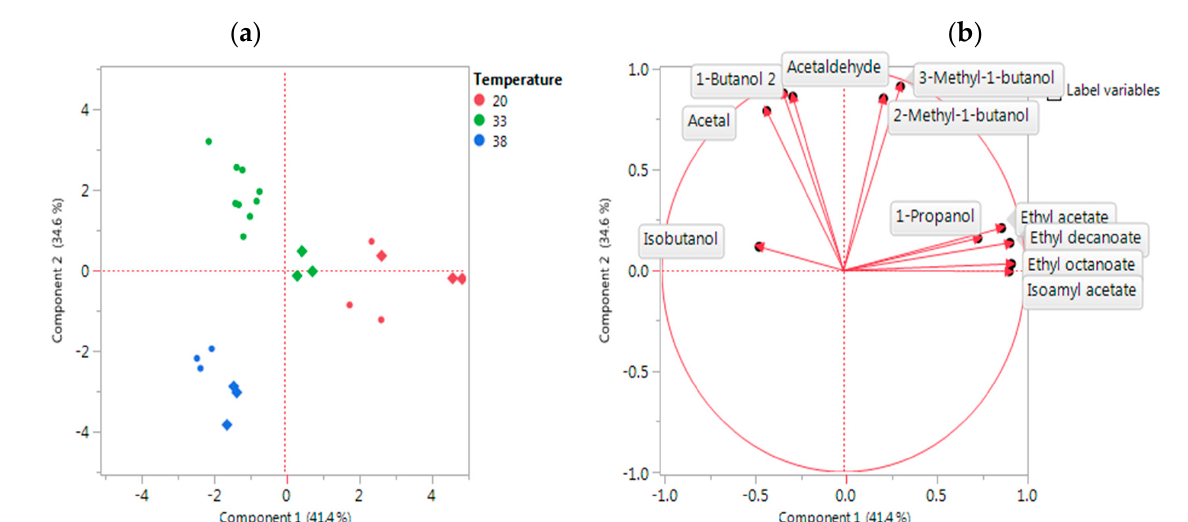
Figure 2. PCA of congener data obtained following corn-whisky fermentation at 20 ◦ C, 33 ◦ C, and 38 ◦ C using a neutral yeast strain (circles) and a whisky yeast strain (diamonds). ( a ) Scores plot ( b ) Loadings plot.